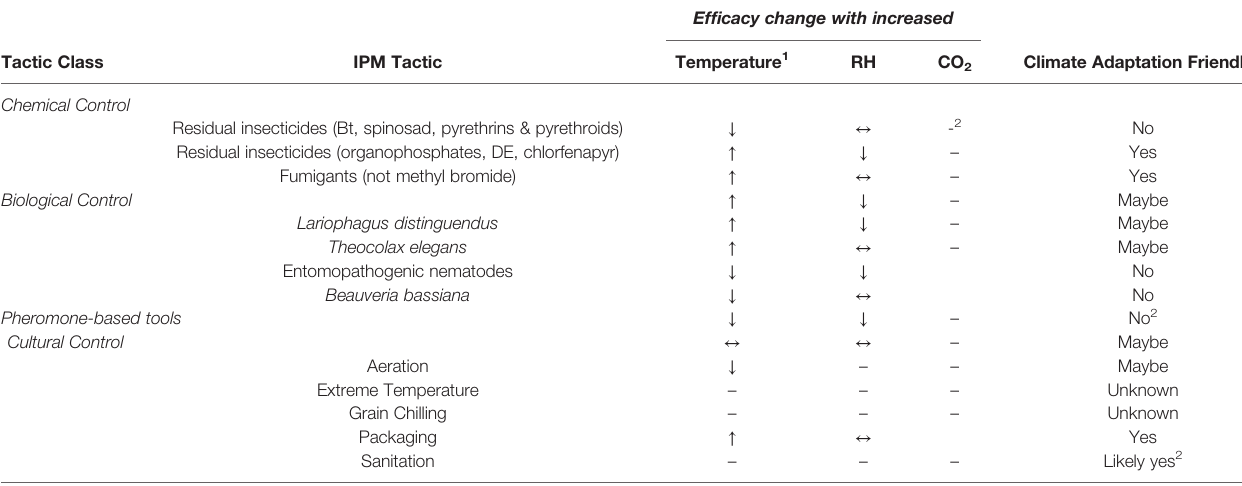
TABLE 1 | Summary of climate adaptation-friendly IPM tactics at food facilities based on prior